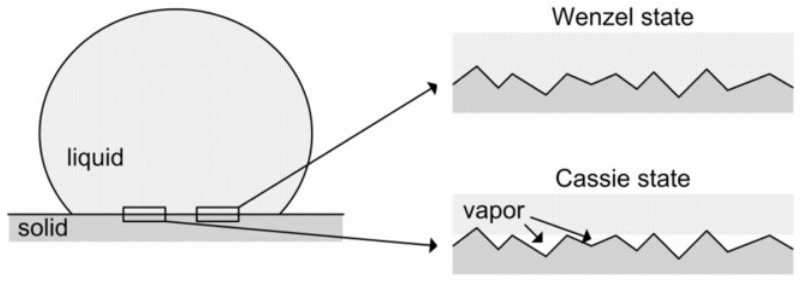
Figure 4. CA determination on a solid surface